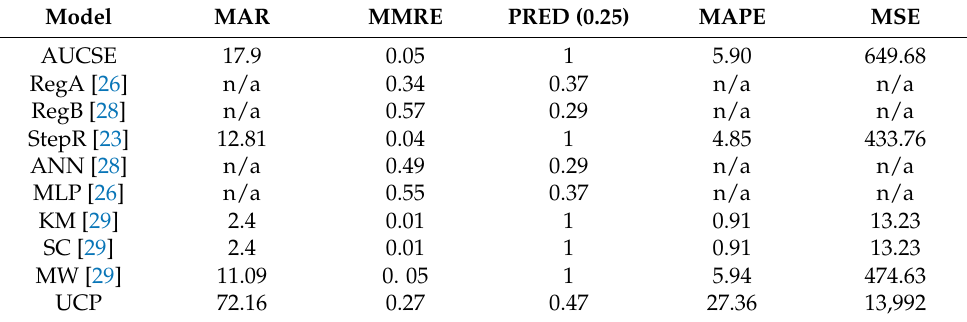
Table 4. Comparison of AUCSE to methods based on